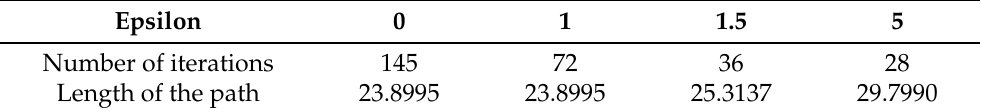
Table 2. Optimal path for different (cid:101) using the weighted A* algorithm.